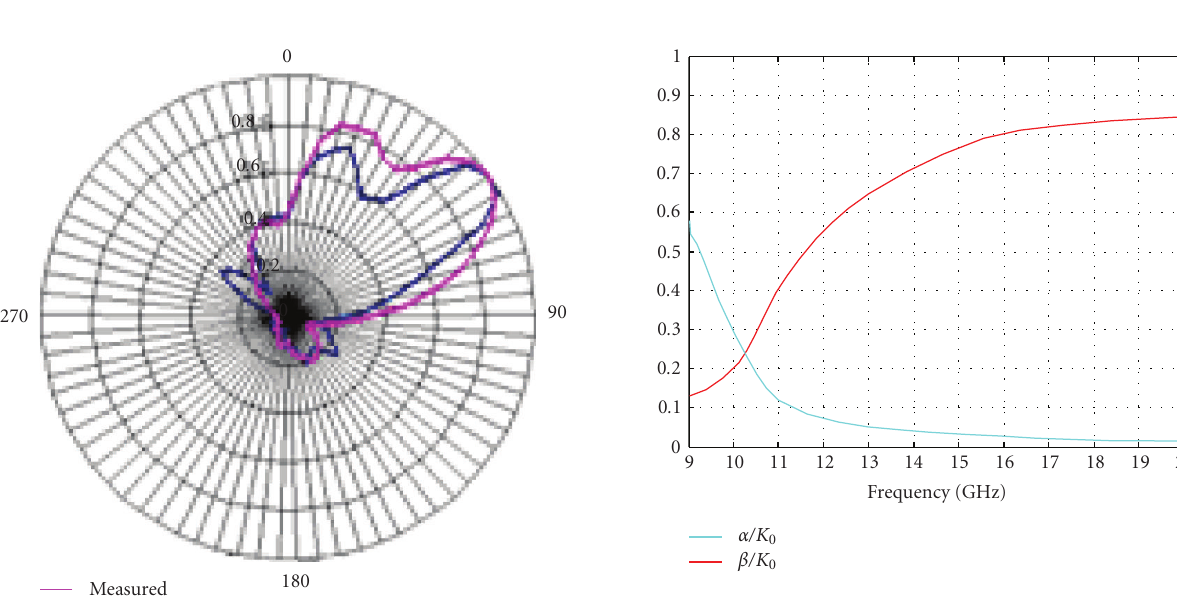
Figure 12: The measured and simulated return loss of half tapered LWA.